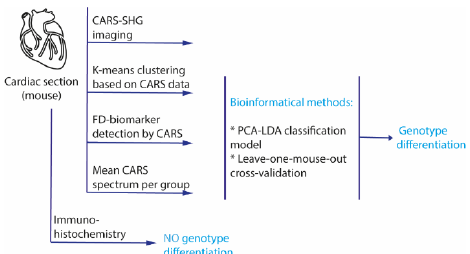
Figure 1. Schematic presentation of the workflow. Briefly, the unstained mouse heart sections were imaged using a CARS-SHG microscope. Multivariate data analysis was performed by data clustering, biomarker detection, and a classification approach based on the mean CARS spectra to bioanalyti- cally differentiate between GLA KO and GLA WT mice. Additionally, classical immunohistochemical stainings (Gb3) of the cardiac sections of α -Gal A knockout (GLA KO ) and wild-type (GLA WT ) mice were